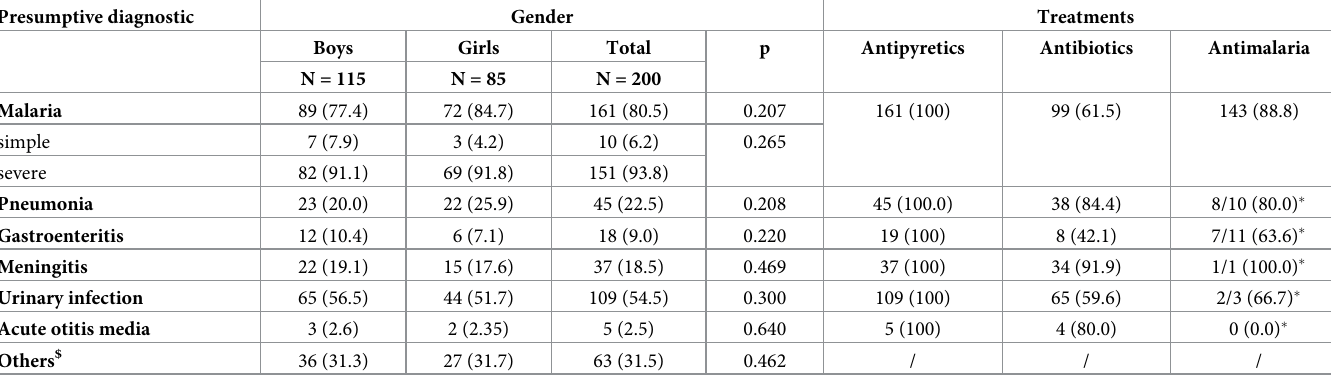
Table 2. Presumptive diagnostic and treatment at initiation.